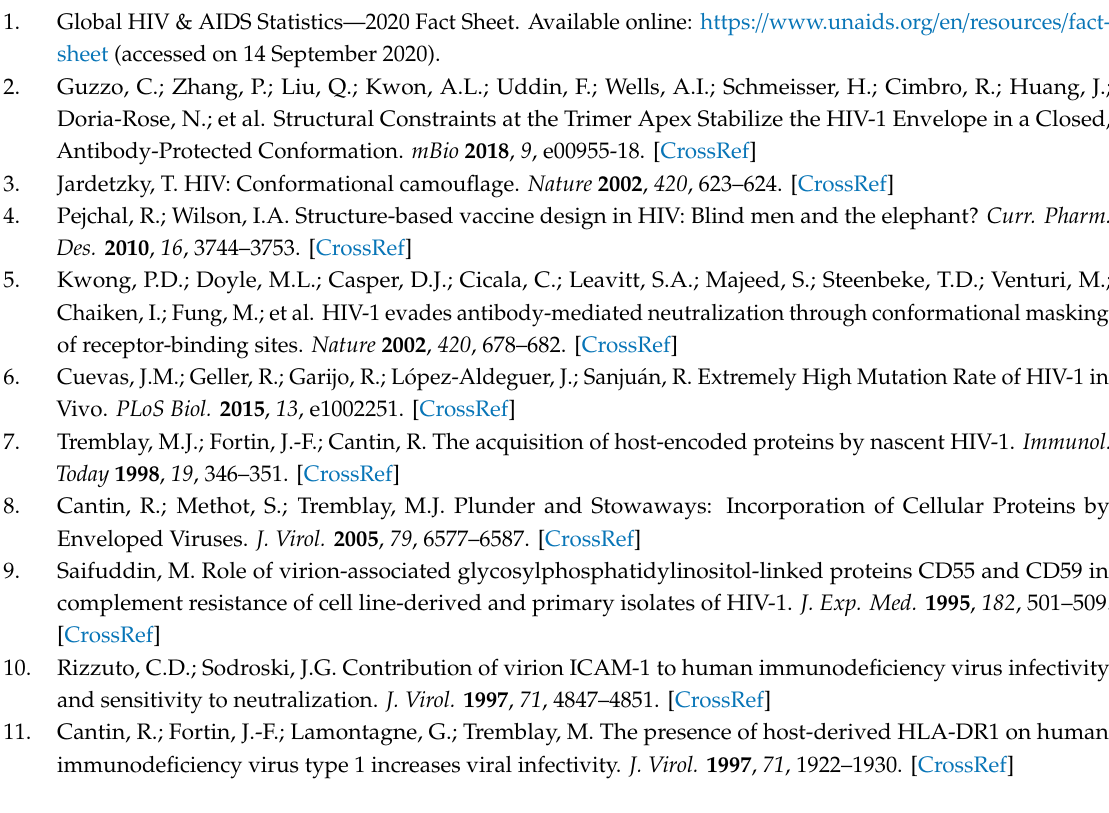
Figure S1: Experimental workflow for flow virometry assays. Figure S2: Unstained virus dilutions and verification of particle concentrations. Figure S3: Light scatter and fluorescence calibration outputs from FCM PASS software. Figure S4: Coincidence and antibody swarming in flow virometry. Figure S5: CD81 is endogenously expressed on the surfaces of HEK293 cells and is not detected in virions via antibody capture assays. Figure S6: Gating strategies used for the phenotypic analysis of cellular proteins on the surface of HIV pseudoviruses. Figure S7: Single- and double-staining controls on mock-transfected cell culture supernatants. Table S1: FCM PASS output report with information on the fluorescent and light scattering calibrations. Table S2: MIFlowCyt-EV